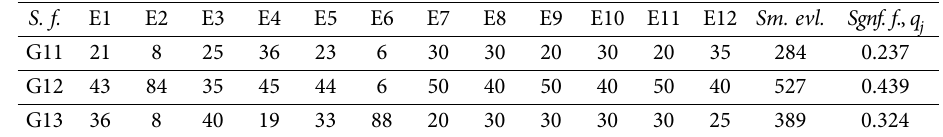
Table 20. The significance of factors in the group of a legal environment (for legal protected technology) regarding the commercial potential of technologies S. f.